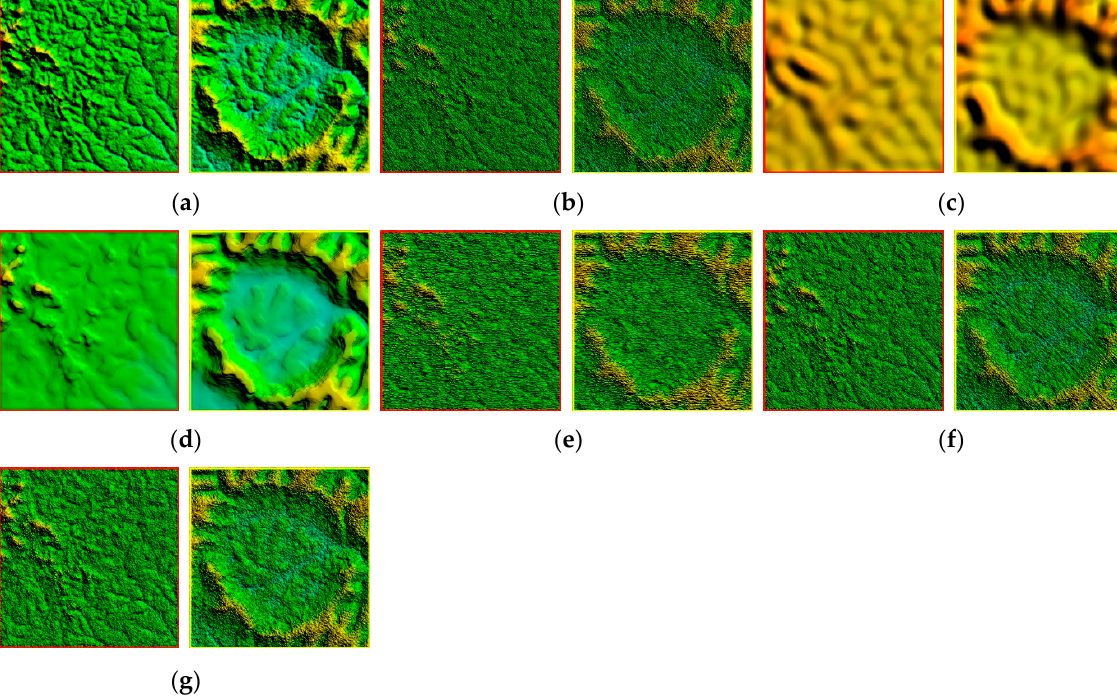
Figure 8. Local enlargement of the results of the simulation experiment for area N01E12 (Figure 7). Local enlargements for ( a ) area N01E12, ( b ) mixed error added, ( c ) low-pass filter, ( d ) TV, ( e ) UTV, ( f ) LRSID and ( g ) LRGS.